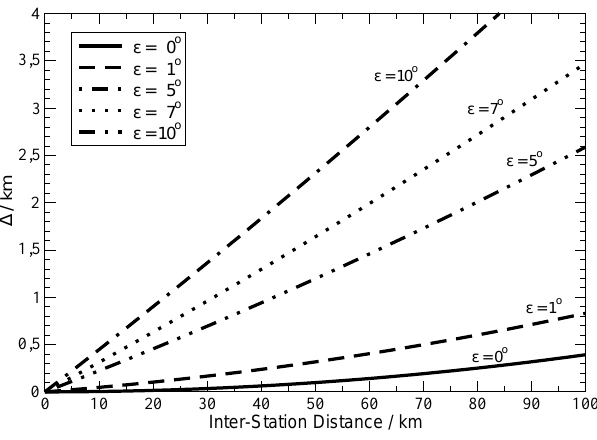
Fig. 2. Minimum altitude of intersecting ray paths as a function of the elevation ε min in the local horizon system and the inter-station distance S AB /2.